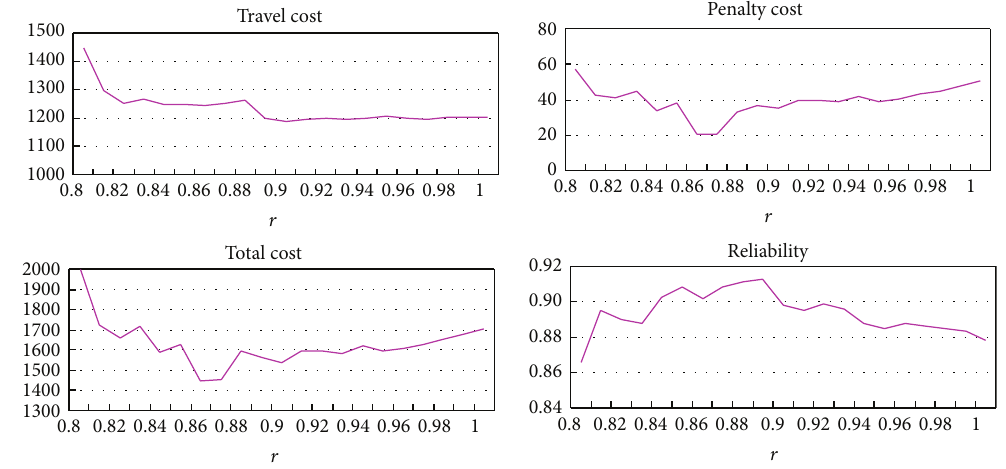
Figure 2: The changing trends of travel costs, penalty costs, total costs, and reliabilities for all values of 𝑟 .